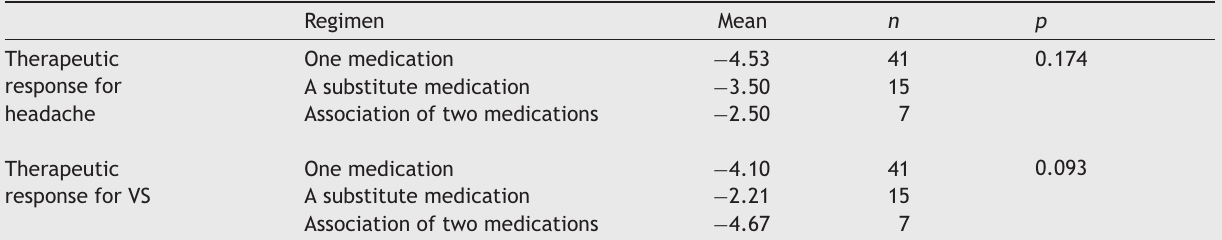
Comparison of the therapeutic responses measured by VAS among the three treatment regimens used: a medication, a substitute medication after the failure of the first one and association of two drugs.